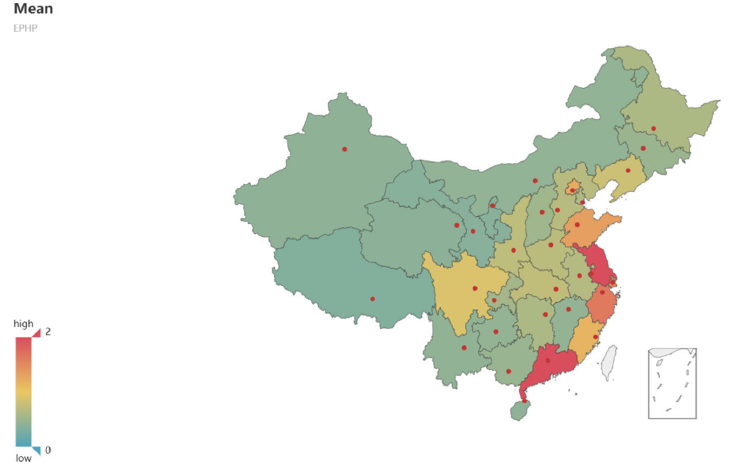
Figure 3. Mean value of the public health provision service efficiency in eastern, middle and western areas.